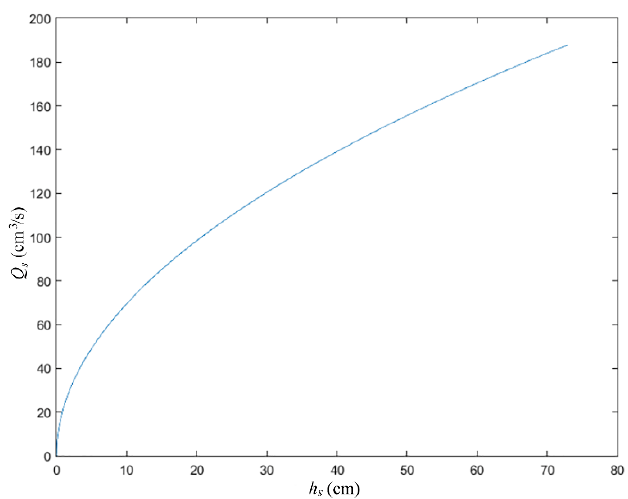
Figure 2. Characteristic curve of the stationary state of the tank under study.